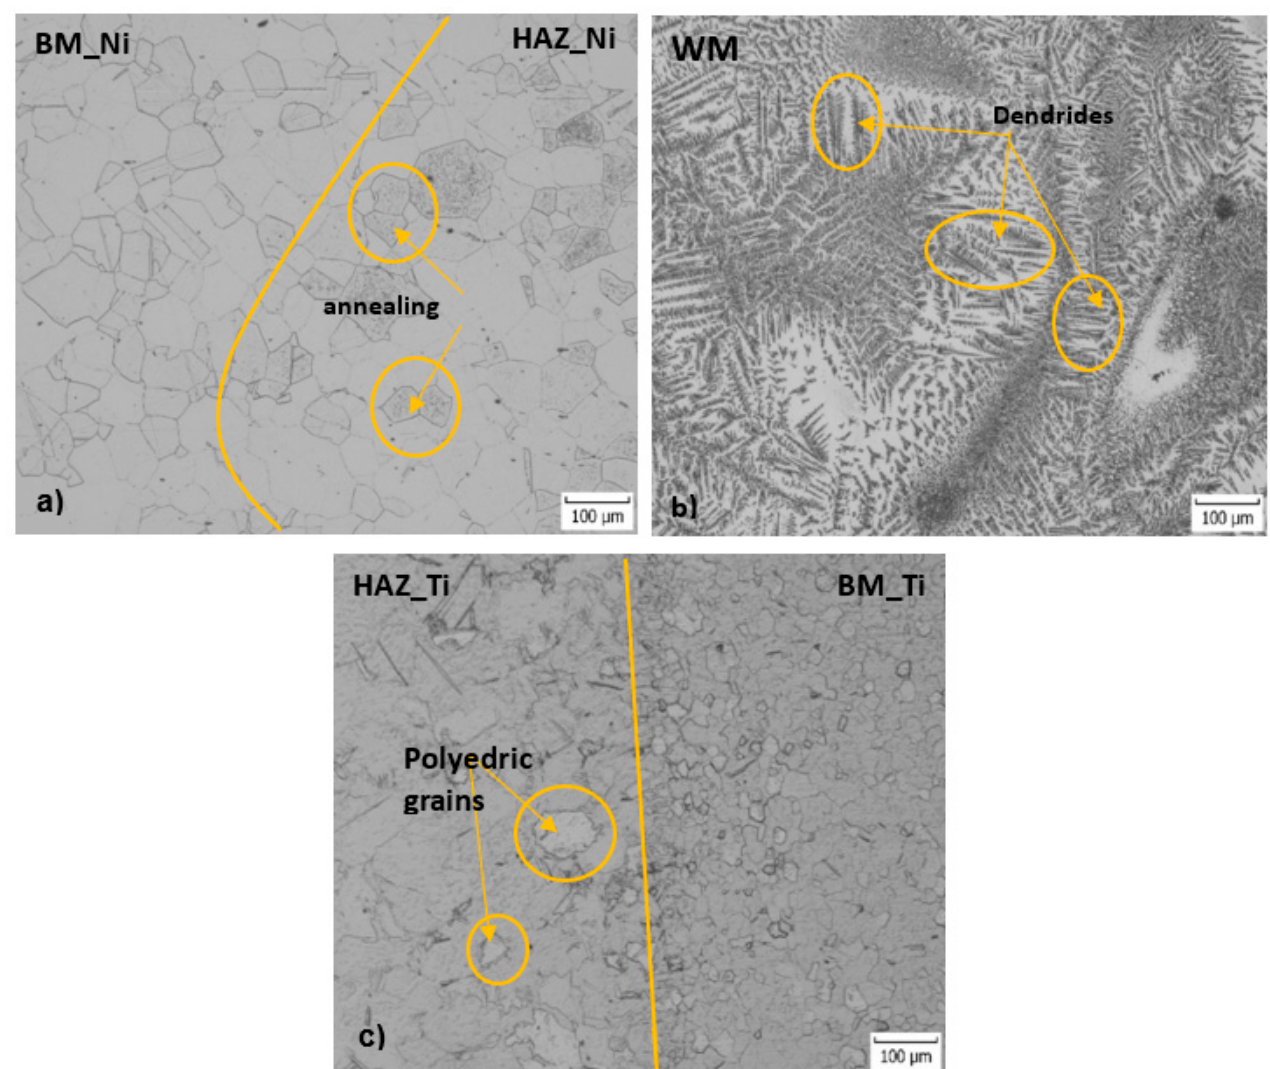
Figure 7. Nickel–HAZ transition zone of weld 8 ( a ); weld metal 8 ( b ); titanium–HAZ-base metal of weld 8 ( c ).